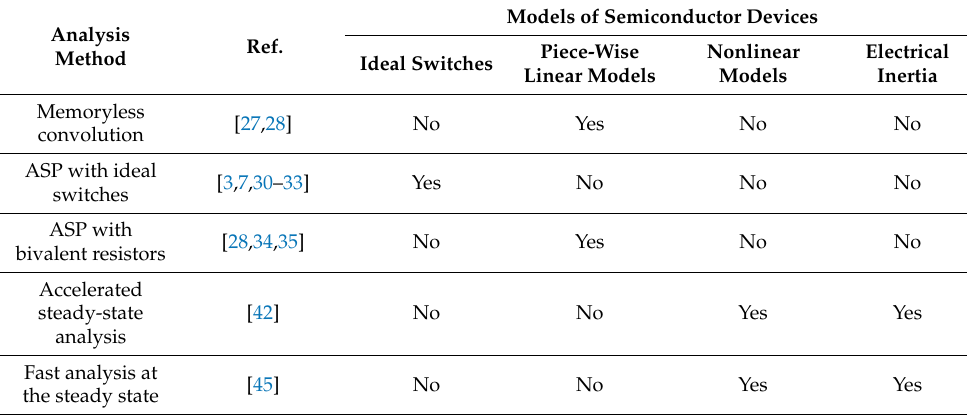
Table 1. Properties of the methods of the isothermal transient analysis. Analysis Method